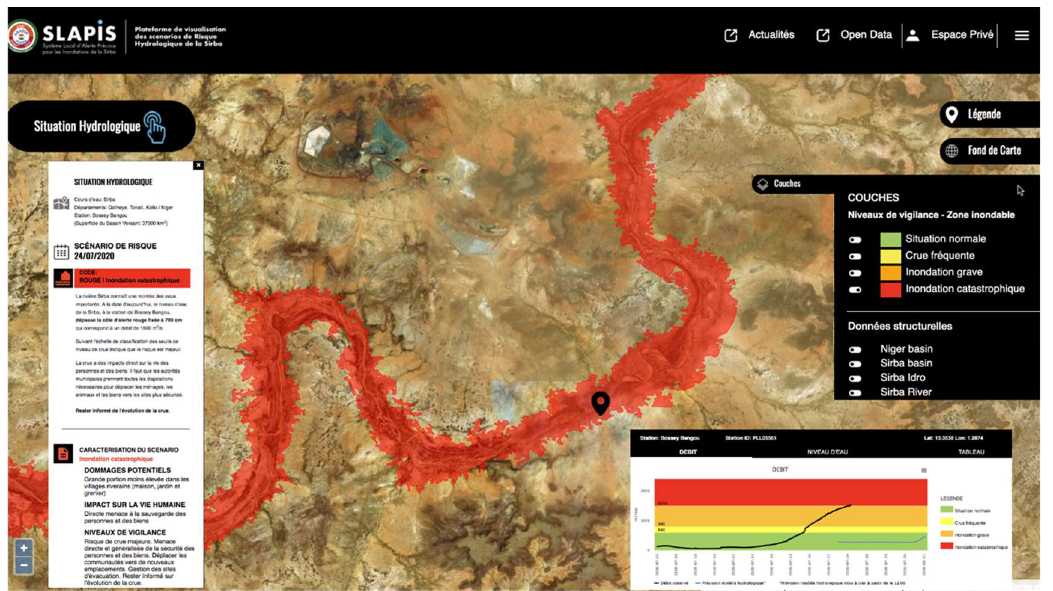
Figure 6. Information flow chart.